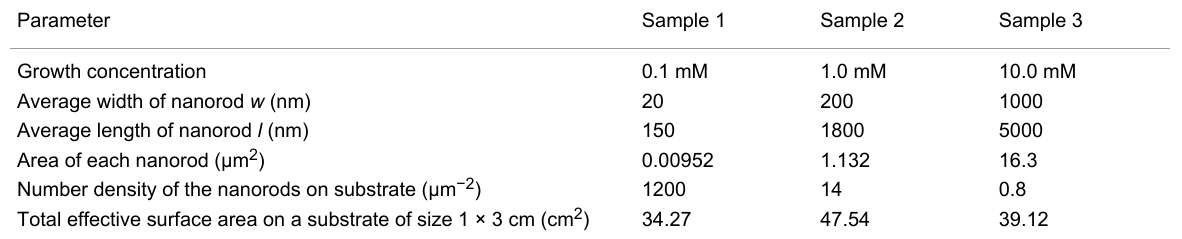
Table 1: Estimated effective area of ZnO nanorod surfaces on substrates of size 1 × 3 cm, grown at different reactant concentrations during the hydrothermal growth process at 90 °C with equimolar concentrations of zinc nitrate and hexamine in the starting aqueous solution.